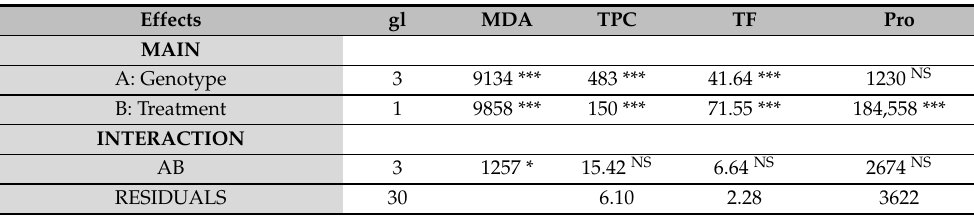
Table 2. Analysis of variance of biochemical assays. The columns show the mean square values of the analysis for malondialdehyde (MDA), total phenolic compounds (TPC), flavonoids (TF) and proline (Pro). Effects gl MDA TPC TF Pro MAIN A: Genotype 3 9134 *** 483 *** 41.64 *** 1230 NS B: Treatment 1 9858 *** 150 *** 71.55 *** 184,558 *** INTERACTION AB 3 1257 * RESIDUALS 30 6.10 2.28 3622